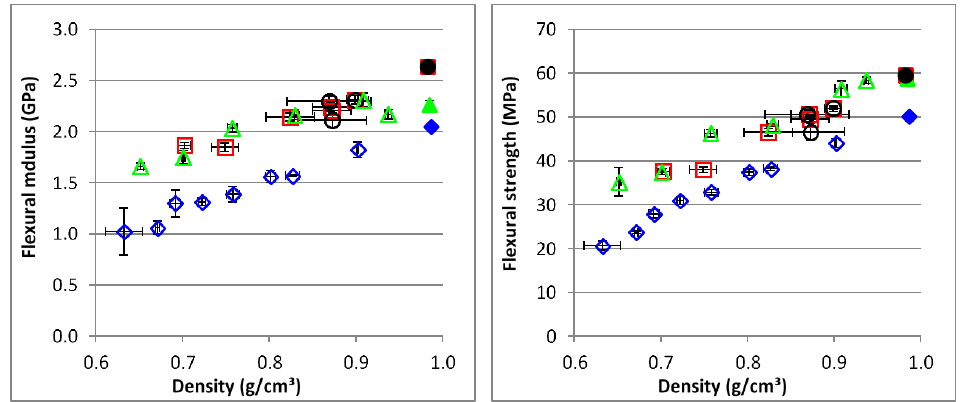
Figure 8. Flexural modulus ( left ) and strength ( right ) of PPCell, foamed with different methods. Legend: Core-back physical (N06_T60)— ; CB_film— ; CB_cent— ; SSh_film— . Solid symbols represent compact samples, open symbols represent foamed samples. Error bars show 95% confidence interval. If not visible, error bars lie within the size of the used symbol for the respective sample.